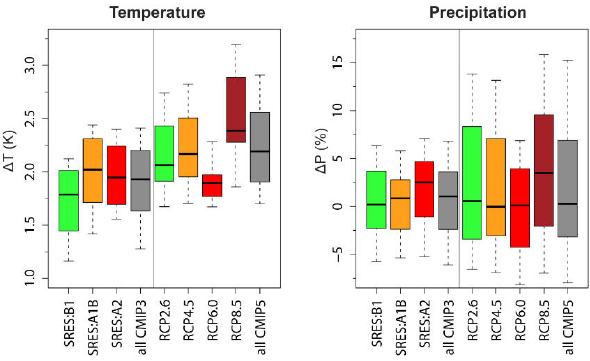
Fig. 9. Box-whisker plots for projected changes in temperature (left) and precipitation (right) for three AR4 SRES emission scenarios and four AR5 representative concentration pathways extracted from the CMIP3 (SRES) and CMIP5 (RCP) databases. The A1B (53 GCM runs), A2 (36 runs) and B1 (44 runs) AR4 scenarios are used and the RCP2.6 (26 runs), RCP4.5 (32 runs), RCP6.0 (17 runs) and RCP8.5 (29 runs) AR5 scenarios are used. The values are mean delta change values for GCM grid cells covering the study area and represent the change over 60 years (1961-1990 to 2021-2050). The boxes represent the range from Q25 to Q75, divided by the median value (Q50). The whiskers represent the range between Q10 and Q25 (at the lower end of the distributions) and the range between Q75 and Q90 (at the higher end of the distributions).